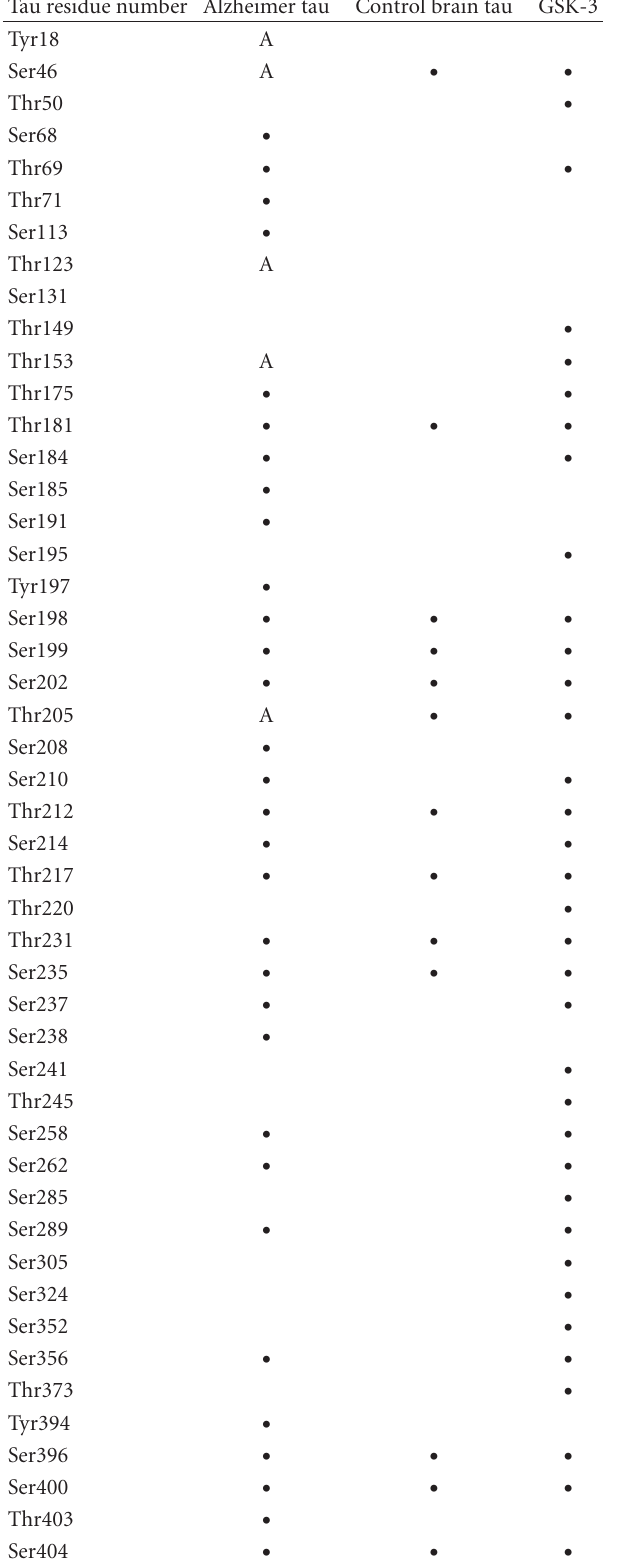
Table 1: Comparison of phosphorylation sites in human Alzheimer and control brain with recombinant tau phosphorylated by GSK-3 in vitro.